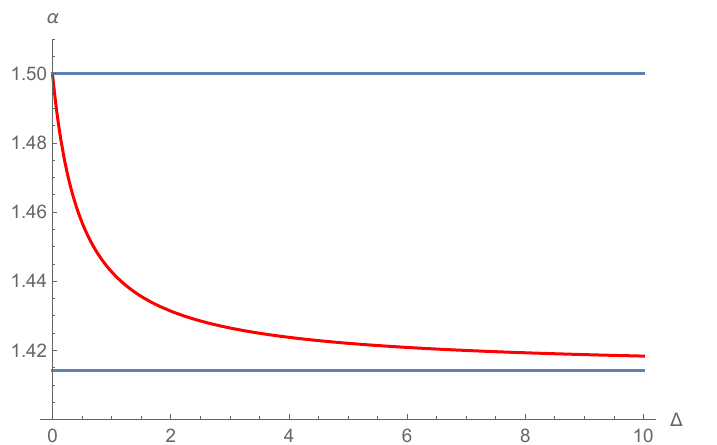
Figure 7 . The red curve is (cid:11) (5.2) as a function of (cid:1). The value of (cid:11) is bounded in a narrow region with the upper bound given by 3 = 2 ((cid:1)